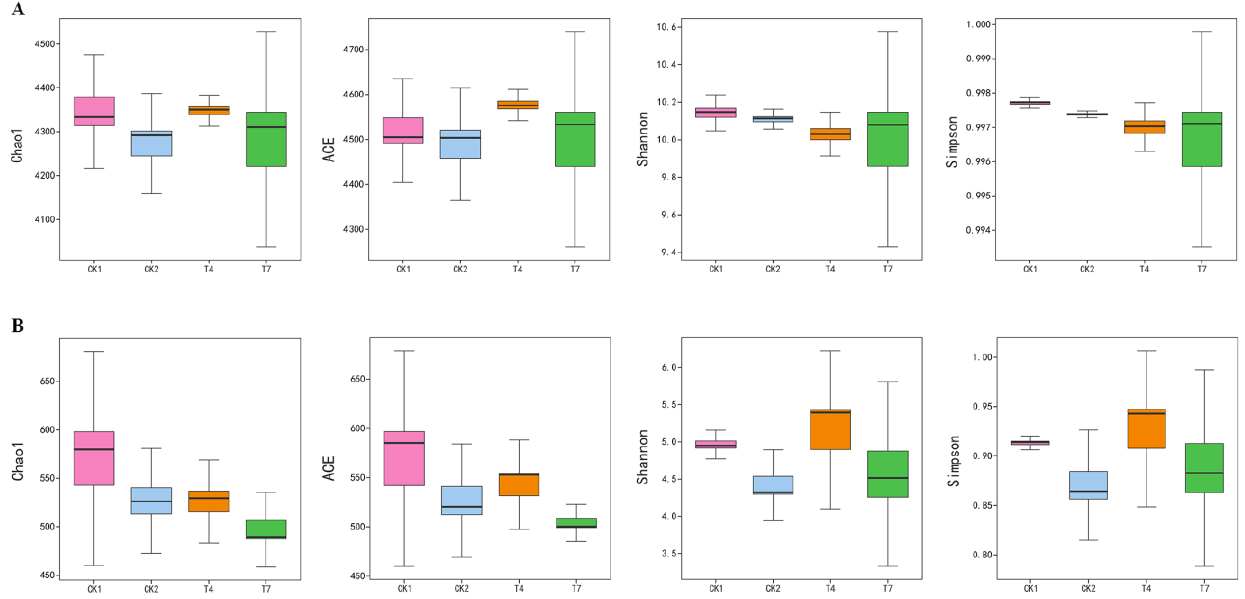
Figure 2. Effect of different composting treatments on the α -diversity of soil microbial communities. ( A ) α -diversity of the bacterial communities in rhizosphere soil. ( B ) α -diversity of the fungal communities in rhizosphere soil.